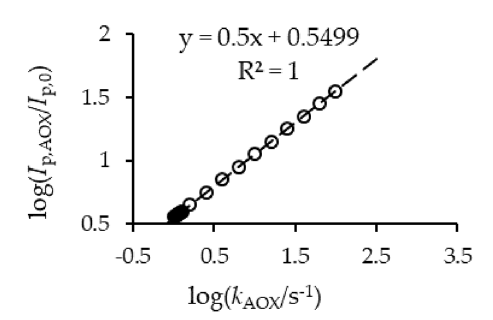
Figure 4. Linear calibration curve and equation constructed by theoretical simulations of the ErC’ reaction mechanism, where log is the base 10 logarithm, Ip,AOX and Ip,0 are anodic peak currents in the presence and the absence of an antioxidant, respectively, k AOX (s − 1 ) is the antioxidant capacity constant (or apparent constant) and R 2 is the square of linear correlation